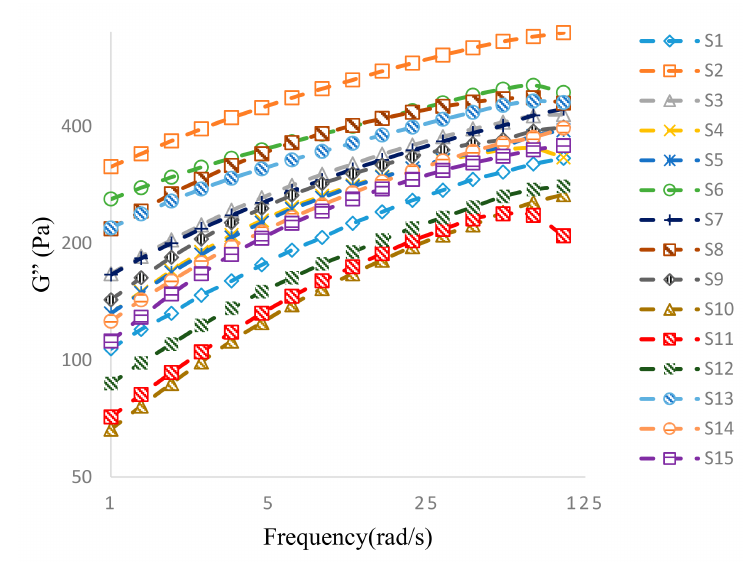
Figure 4. Evolution of G” as a function of the applied frequency for samples of felbinac cataplasms.